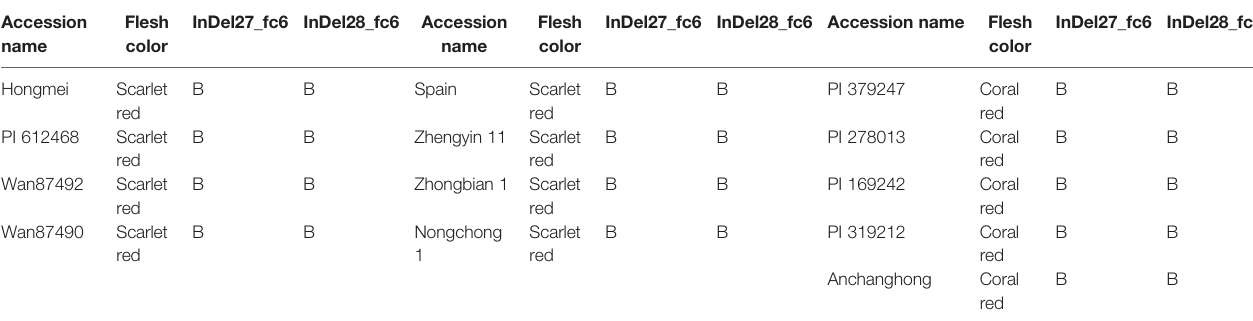
SUPPLEMENTARY FIGURE 1 | Clustal multiple sequence alignment